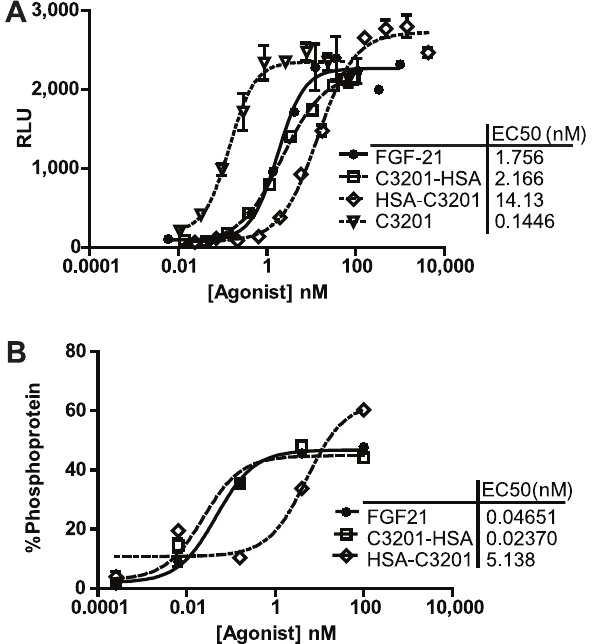
Figure 3. Characterization of C3201-HSA fusions. (A) Fusions of C3201 and HSA induce luciferase activity on an FGF21-responsive engineered reporter cell line following four hour stimulation of serum- starved cells. Potency is influenced by the orientation of the fusion. Luciferase activity is measured in relative luminescence units (RLU). Data are represented as mean + / 2 SEM (n=2). (B) Fusions of C3201 and HSA induce ERK phosphorylation in cultured primary human adipo- cytes. Potency is influenced by the orientation of the fusion. Data are expressed as % ERK protein that is phosphorylated, as measured by MSD.